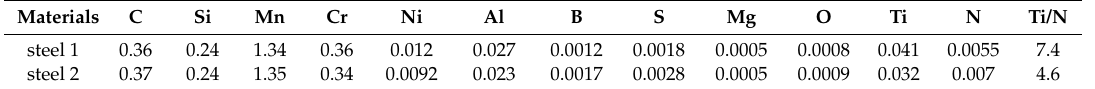
Table 1. The Ti/N ratio of steel 1 was 7.4, higher than steel 2 (4.6), as shown in Table 1. Table 1. Chemical compositions of experimental specimens